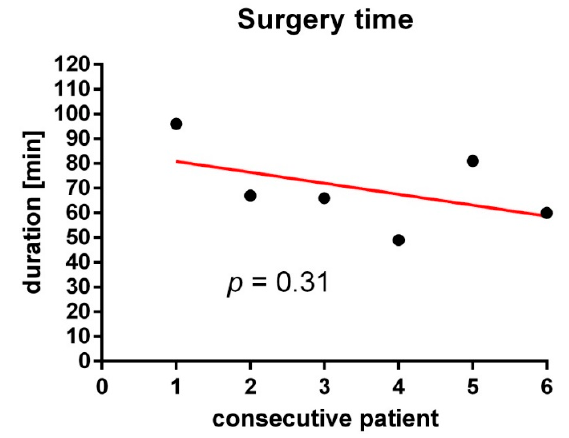
Figure 1. Duration of the shunt implantation procedure of consecutive patients as measured by the time interval from skin incision until skin suture.